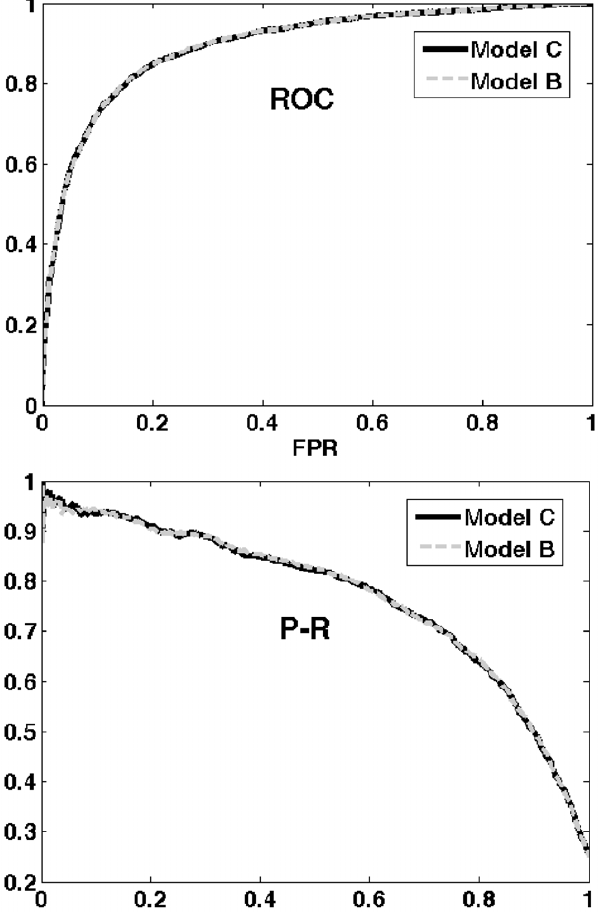
Figure 2. Two examples of peptide clusters. The figure shows two examples of a positive cluster (top) and a negative cluster (bottom). Each cluster of peptide is described by its multiple alignments (on the right top of each sub-figure) and by its representation through sequence logo [49]. This graphical representation displays the conservation of the amino acids in each position of the multi-alignment by their one-letter code. Different residues at the same position are scaled according to their frequency. In particular the height of the entire stack of residues is the information measured in bits (y-axis).